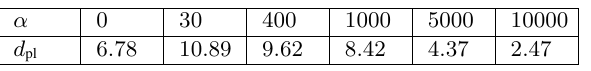
Table 7: Mean Euclidean distance d pl between the planes at the beginning and end of test scene II for different values of α